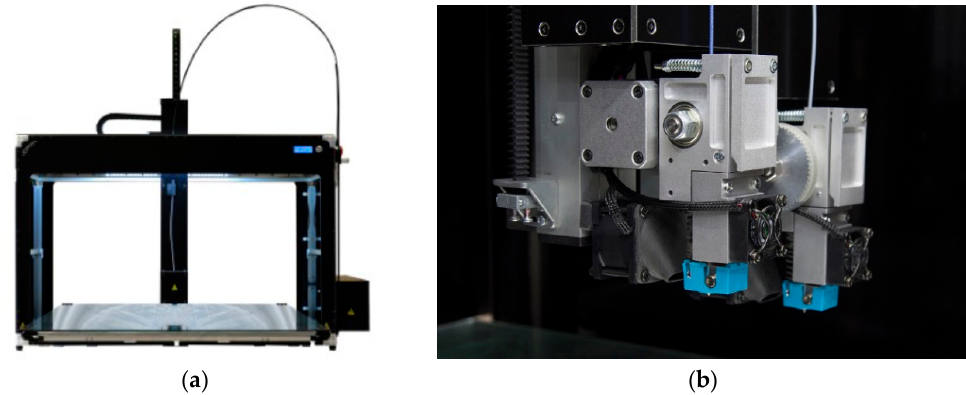
Figure 8. ( a ) Testing 3DPRN LAB H5 FDM printer; ( b ) dual-extrusion setup utilized for test.